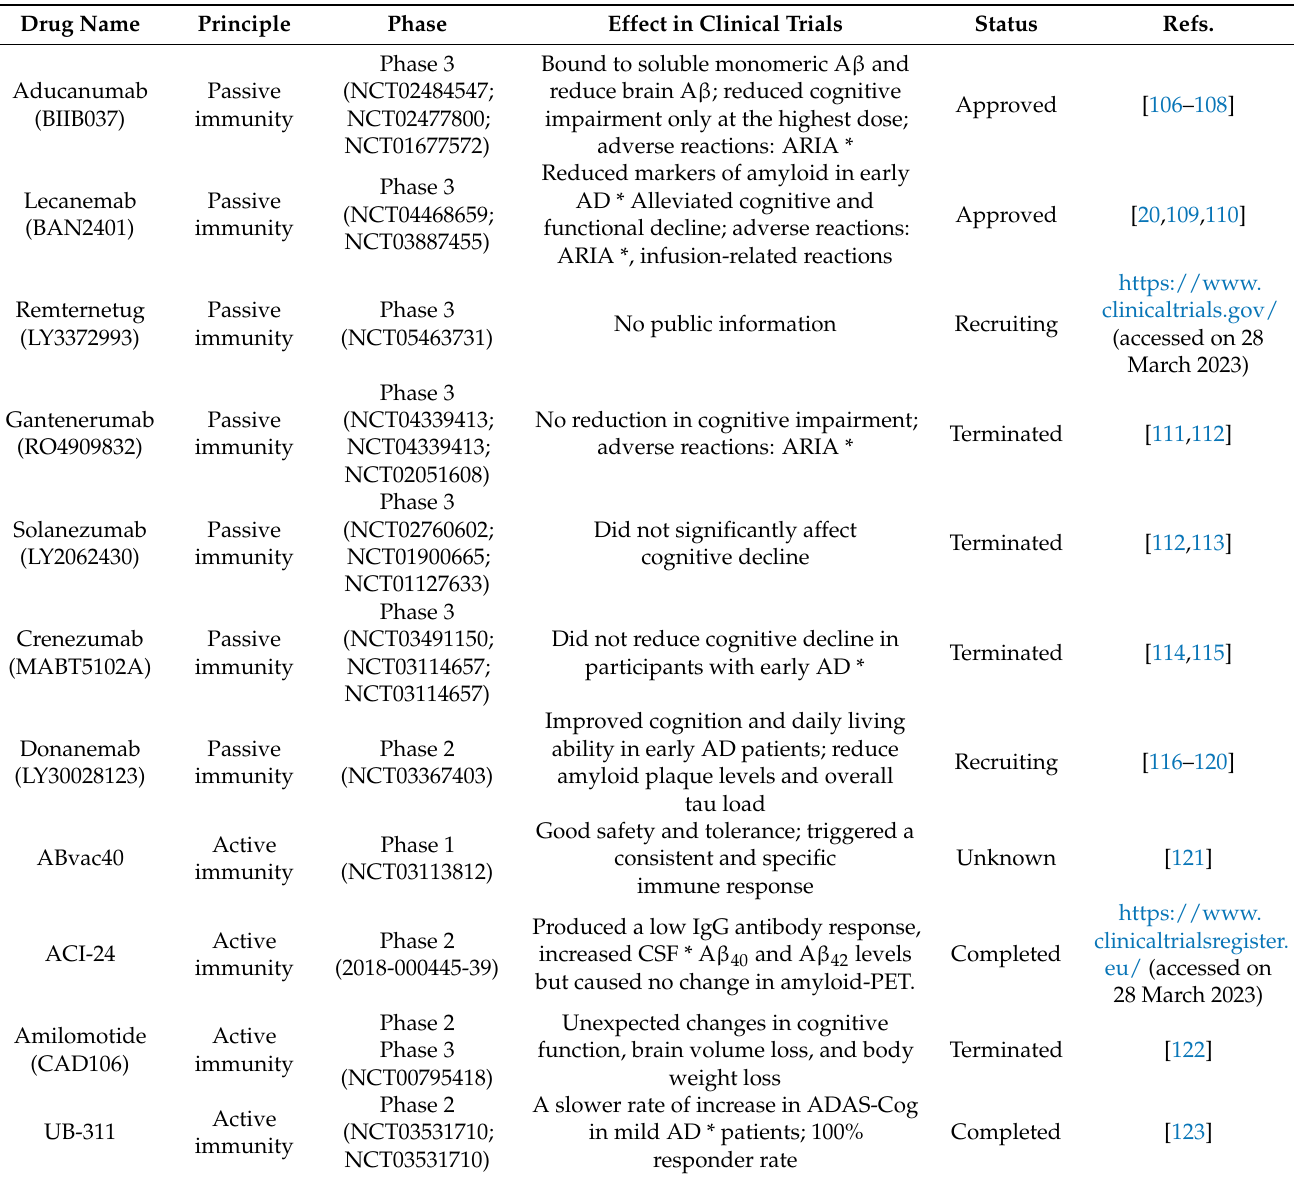
Table 3. Alzheimer drugs to promote A β